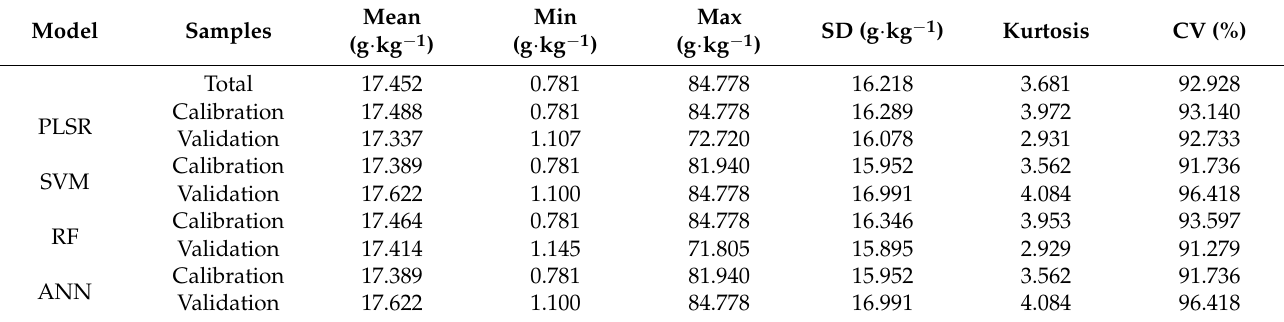
Table 3. Description of SOC predictions from four